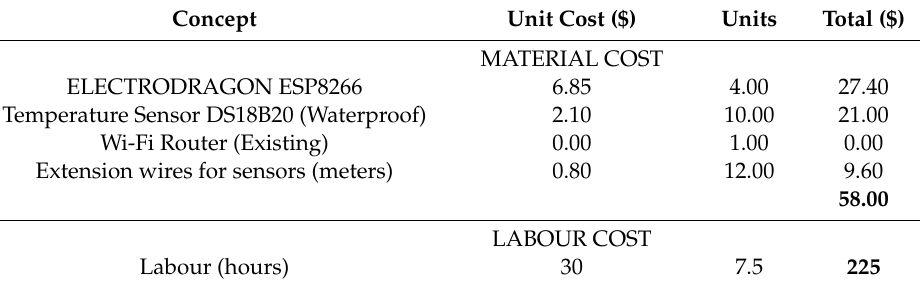
Table 8. Implemented solution cost.